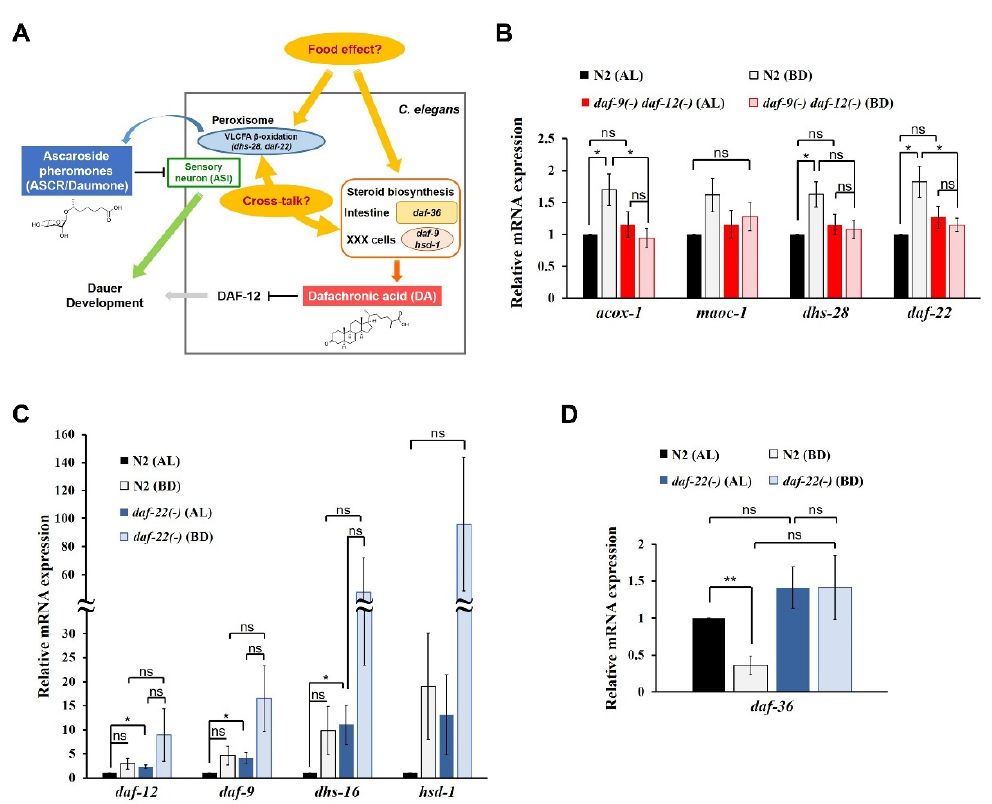
Figure 1. Reciprocal regulation of ASCRs and DAs by dietary cues in C. elegans . ( A ) A schematic diagram showing a model of reciprocal regulation between ASCRs (ascaroside pheromones) and DAs (dafachronic acid hormones) in C. elegans . VLCFA, very long chain fatty acid. The chemical structures of the major subtype of ASCR (ascr#1) and DA ( ∆ 7 -DA) are shown. ( B ) Relative mRNA expression levels of ASCR biosynthetic genes ( acox-1 , maoc-1 , dhs-28 and daf-22 ) in wild-type N2 and daf-9(dh6) daf-12(rh61 rh411) L4 worms under AL ( ad libitum fed) and BD (bacterial deprivation) conditions. ( C ) Relative mRNA expression levels of DA biosynthetic genes ( daf-9 , dhs-16 and hsd-1 ; daf-12 for DA receptor) in N2 and daf-22(ok693) L4 worms under AL and BD conditions. ( D ) Relative mRNA expression level of DA biosynthetic gene daf-36 in N2 and daf-22(ok693) L4 worms under AL and BD conditions. For ( B–D ), data are shown as mean ± SEM of four biologically independent experiments. * p < 0.05, ** p < 0.01 and ns (not significant) were determined via one-way ANOVA analysis. See the Supplementary tables for the exact p